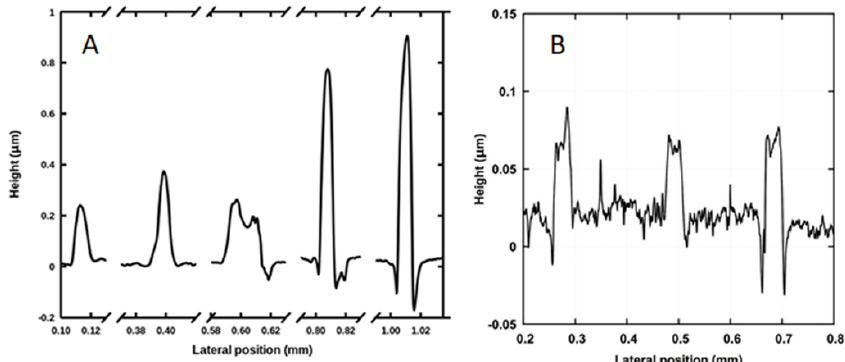
Figure 10. Surface profile of channel waveguides ( A ): As implanted. E = 11 MeV. Irradiated fluences from left to right: 1.0 · 10 14 ions/cm 2 , 2.54 · 10 14 ions/cm 2 , 5.0 · 10 14 ions/cm 2 , 1.0 · 10 15 ions/cm 2 and 1.5 · 10 15 ions/cm 2 . ( B ): After stepwise thermal annealing up to 300 ◦ C. E = 11 MeV. Irradiated fluences from left to right: 1.4 · 10 14 ions/cm 2 , 1.4 · 10 14 ions/cm 2 (the fluence was the same) and 4.6 · 10 14 ions/cm 2